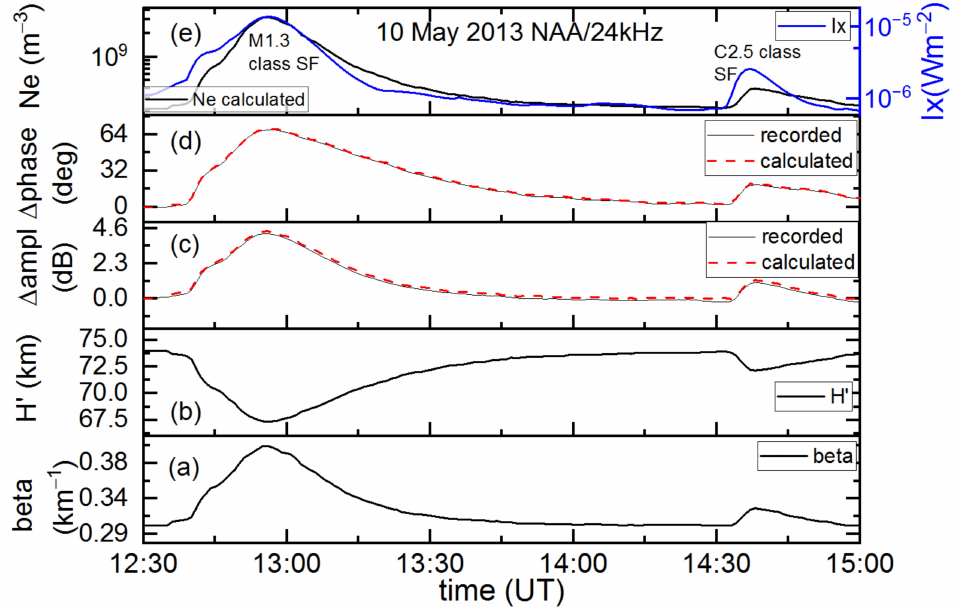
Figure 3. Simultaneous variations of the sharpness β ( a ), effective reflection height H (cid:48) ( b ), VLF amplitude ( c ) and phase ( d ) excess recorded and simulated, electron density at reference height ( e ) and X-ray flux (on the right axis ( e )) during the occurrence of two successive SFs on 10 May 2013.